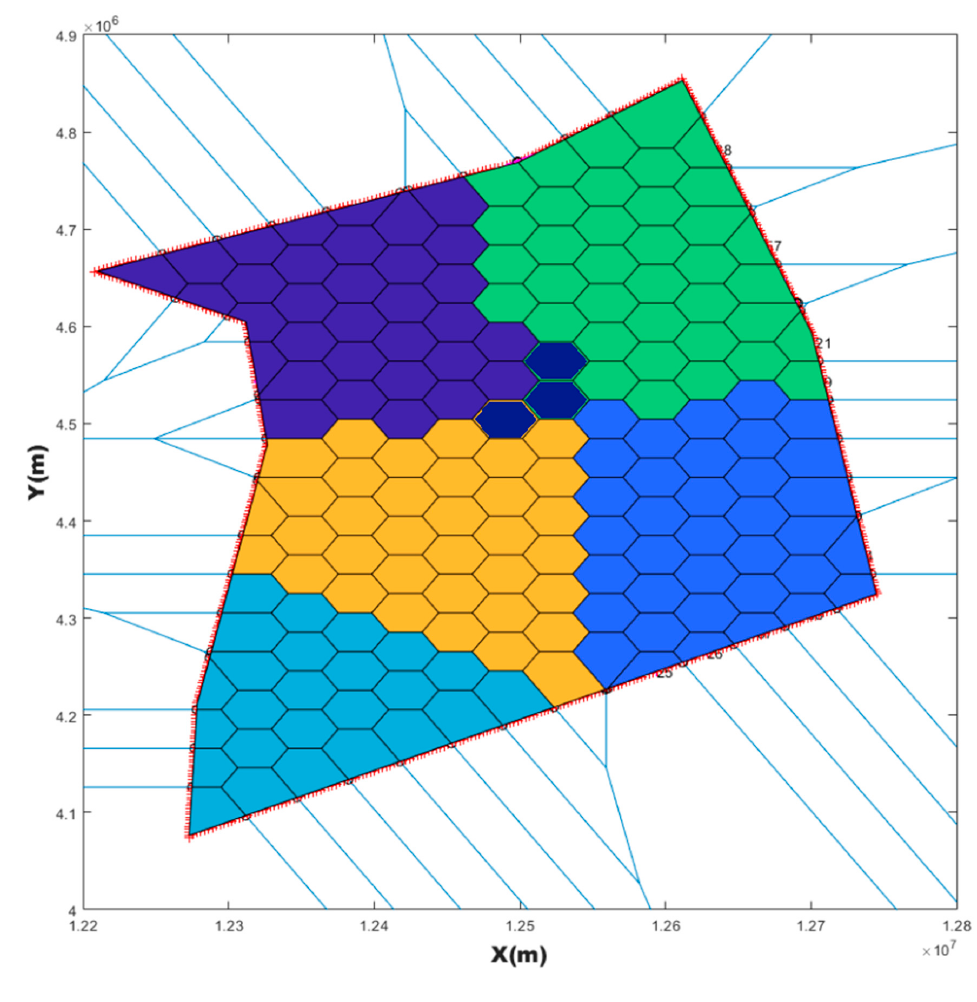
Figure11. Anexampleofexpansibleboundarypoints( a )andexpandedboundaries( b